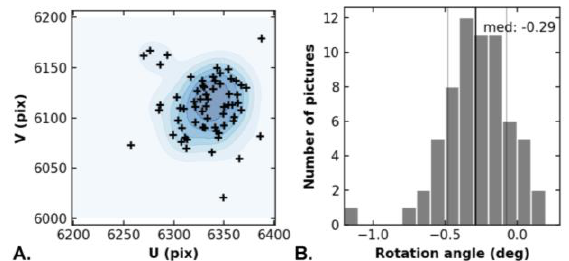
Figure 2. A. Position of the camera fiducial diagonals intersection in the original image reference frame. This central point varies in a domain of 150 x 150 pixels. B. Rotation angle applied to scanned images to align image coordinates to fiducial marks. The median (- 0.29°) and the 17% and 18% quantiles (-0.48 and -0.075) are (Figure 1) (Kraus, 1993): i.e. at least pinning all four corners of represented by the black and grey vertical lines. These show that the area and constraining an elevation span between 266 m and translate, rotate and crop operations are necessary to align images to 3066 m above sea level. Coordinates were encoded in RGR92 UTM40S (EPSG code: 2975). The set of reference points was the camera reference frame. split between 11 Ground Control Points (GCP), and 9 checkpoints to validate the accuracy of the exterior orientation. After the initial orientation process (“Align” operation in Metashape), which uses GCPS coordinates in the bloc bundle adjustment , reference points had precision residuals of 0.72-0.90 pixels (Table 2). This precision remained stable whether the “Medium” or “High” accuracy setting was selected (Table